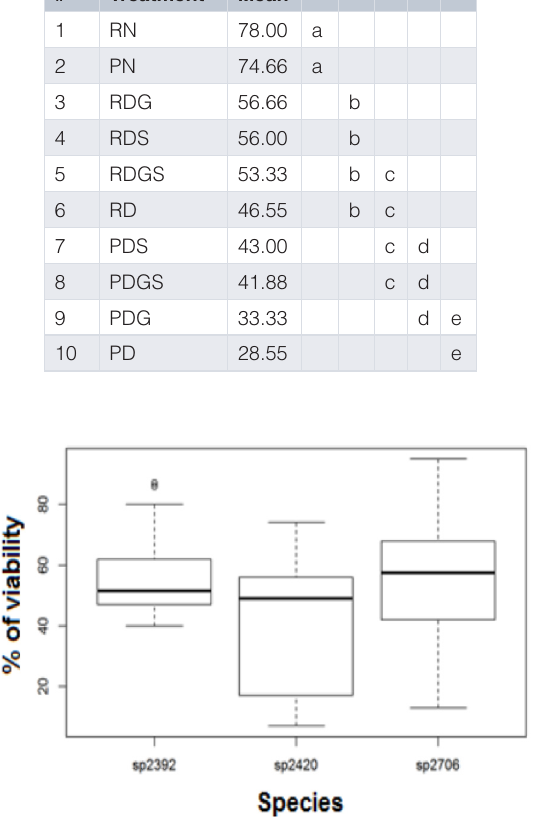
Figure 4. Cryopreservation of seeds: variability by species. Results obtained using the Duncan test, sp2706 (T57.2), sp2392 (T 57.03),